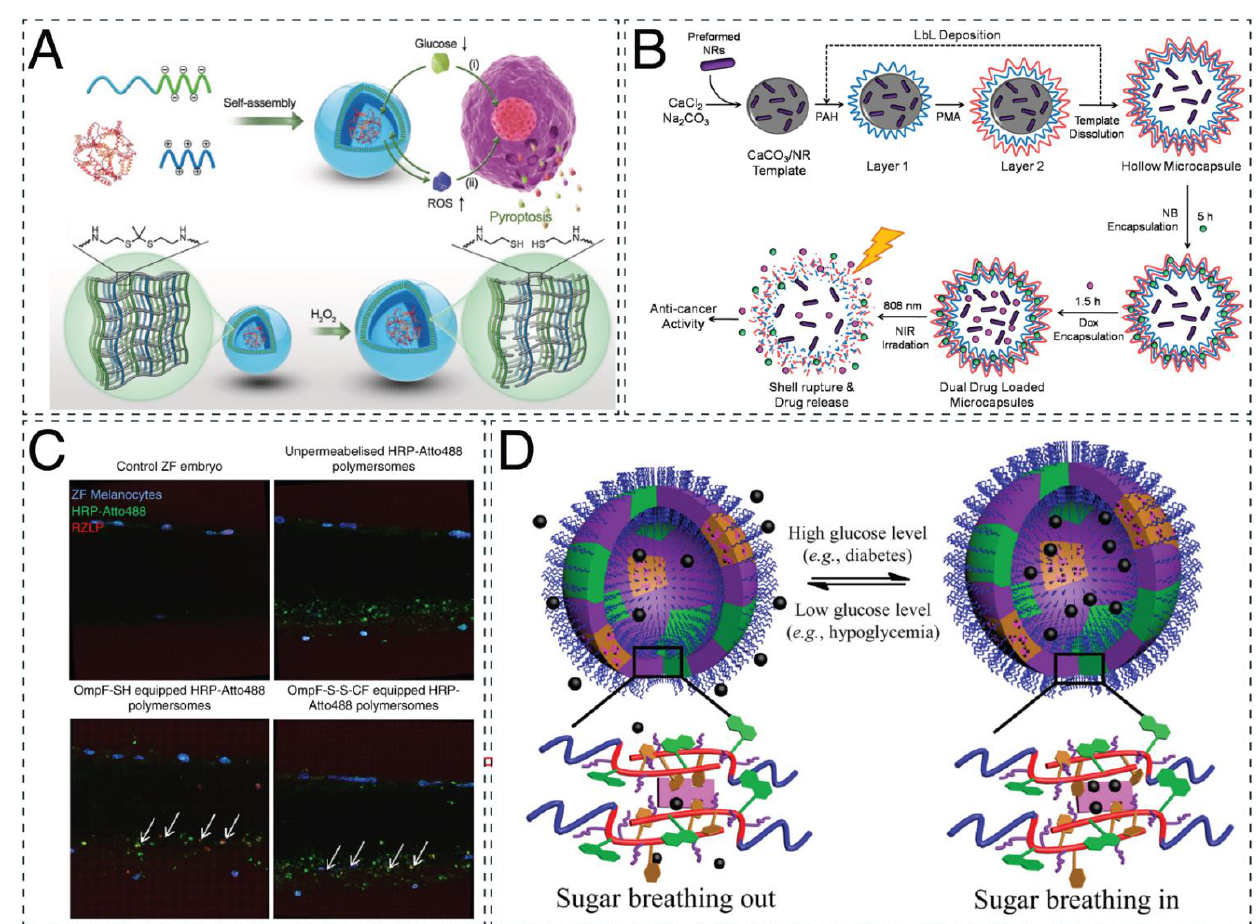
Figure 3. Therapeutic applications of nanocompartments. ( A ) Glucose oxidase -loaded PICsomes for inducing cell death by pyroptosis. Adapted with permission from [65]. Copyright 2020 John Wiley and Sons. ( B ) Layer-by-layer microcapsules for cancer chemophotothermal therapy. Reprinted with permission from [60]. Copyright 2020 Elsevier. ( C ) Biodistribution and activity of HRP-encapsulating polymersomes, acting as artificial organelles in a zebrafish embryo. Adapted with permission from [138]. Copyright 2018 Springer Nature. ( D ) Glycopolymersomes for regulating glucose levels for the treatment of diabetes mellitus. Adapted with permission from [87]. Copyright 2017 American Chemical Society.